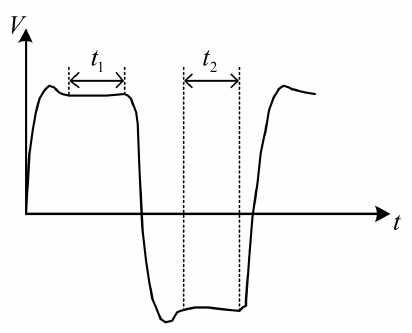
Figure 3. Waveforms at both ends of the sensor.